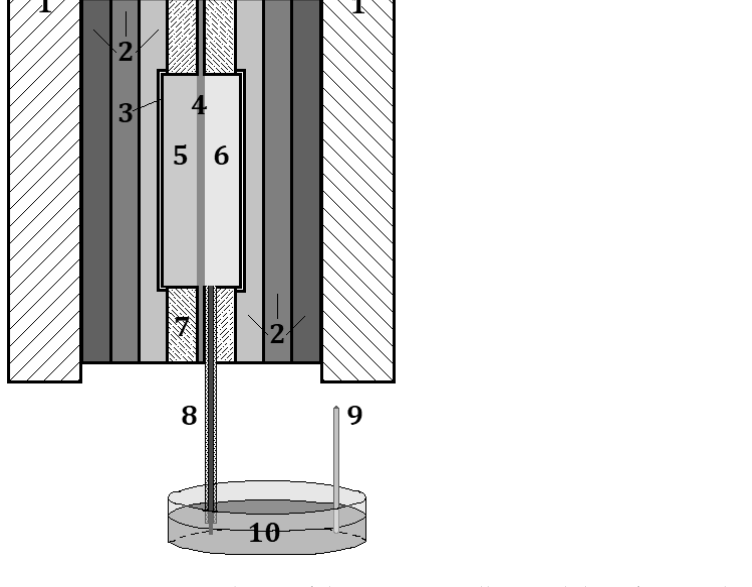
Figure 3. Connection scheme of the Luggin capillary and the reference electrode in the MEA. The attribution of numbers in the figure is described in Section 2.2.4. attribution of numbers in the figure is described in Section